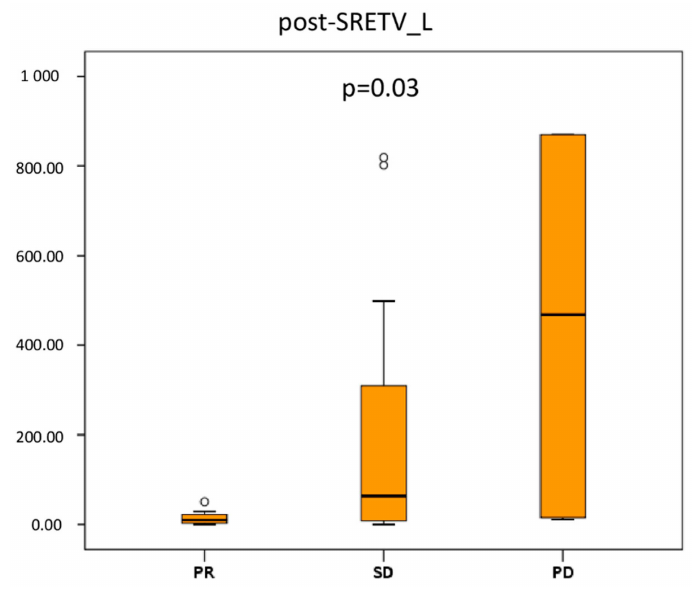
Figure 3. Graphical box ‐ plots representing median values of somatostatin receptor expressing tumor volume (SRETV) for liver tumor burden (_L) at first restaging. Liver tumor burden was significantly greater in patients with progressive disease (PD). Outliers are represented by °.